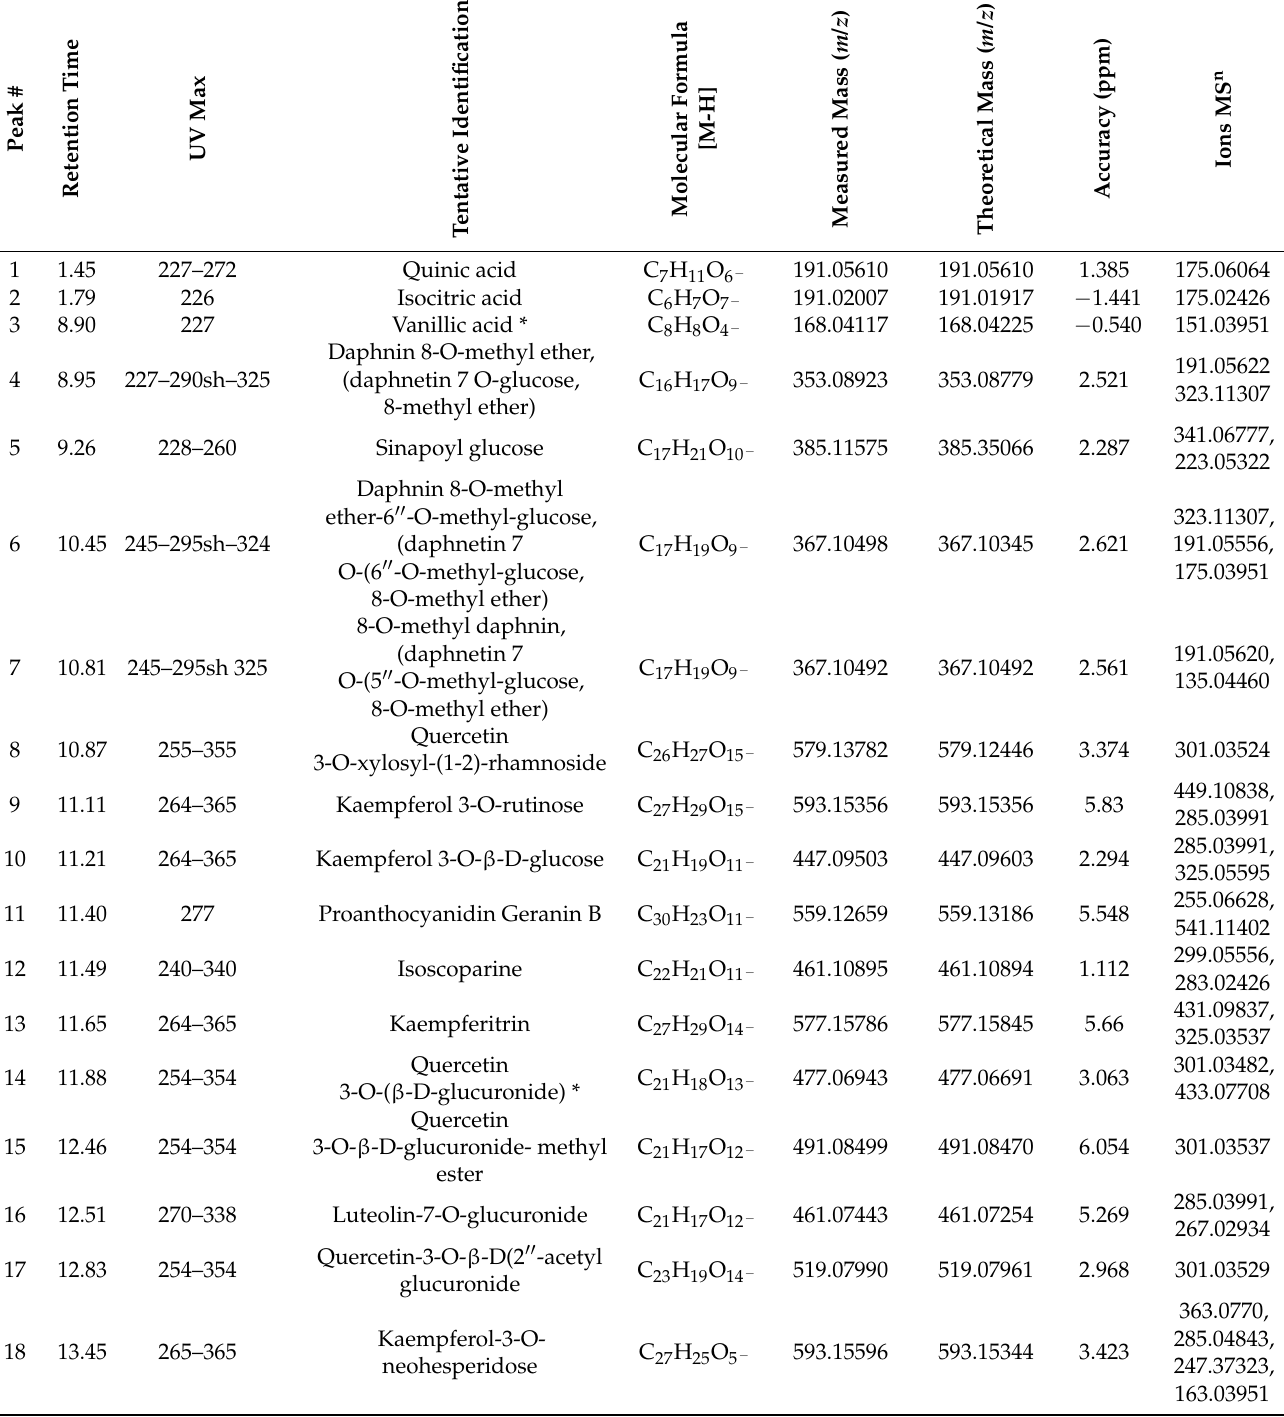
Table 1. UHPLC-PDA-MS identification of the ethanolic extract from Lloime ( Ovidia pillopillo